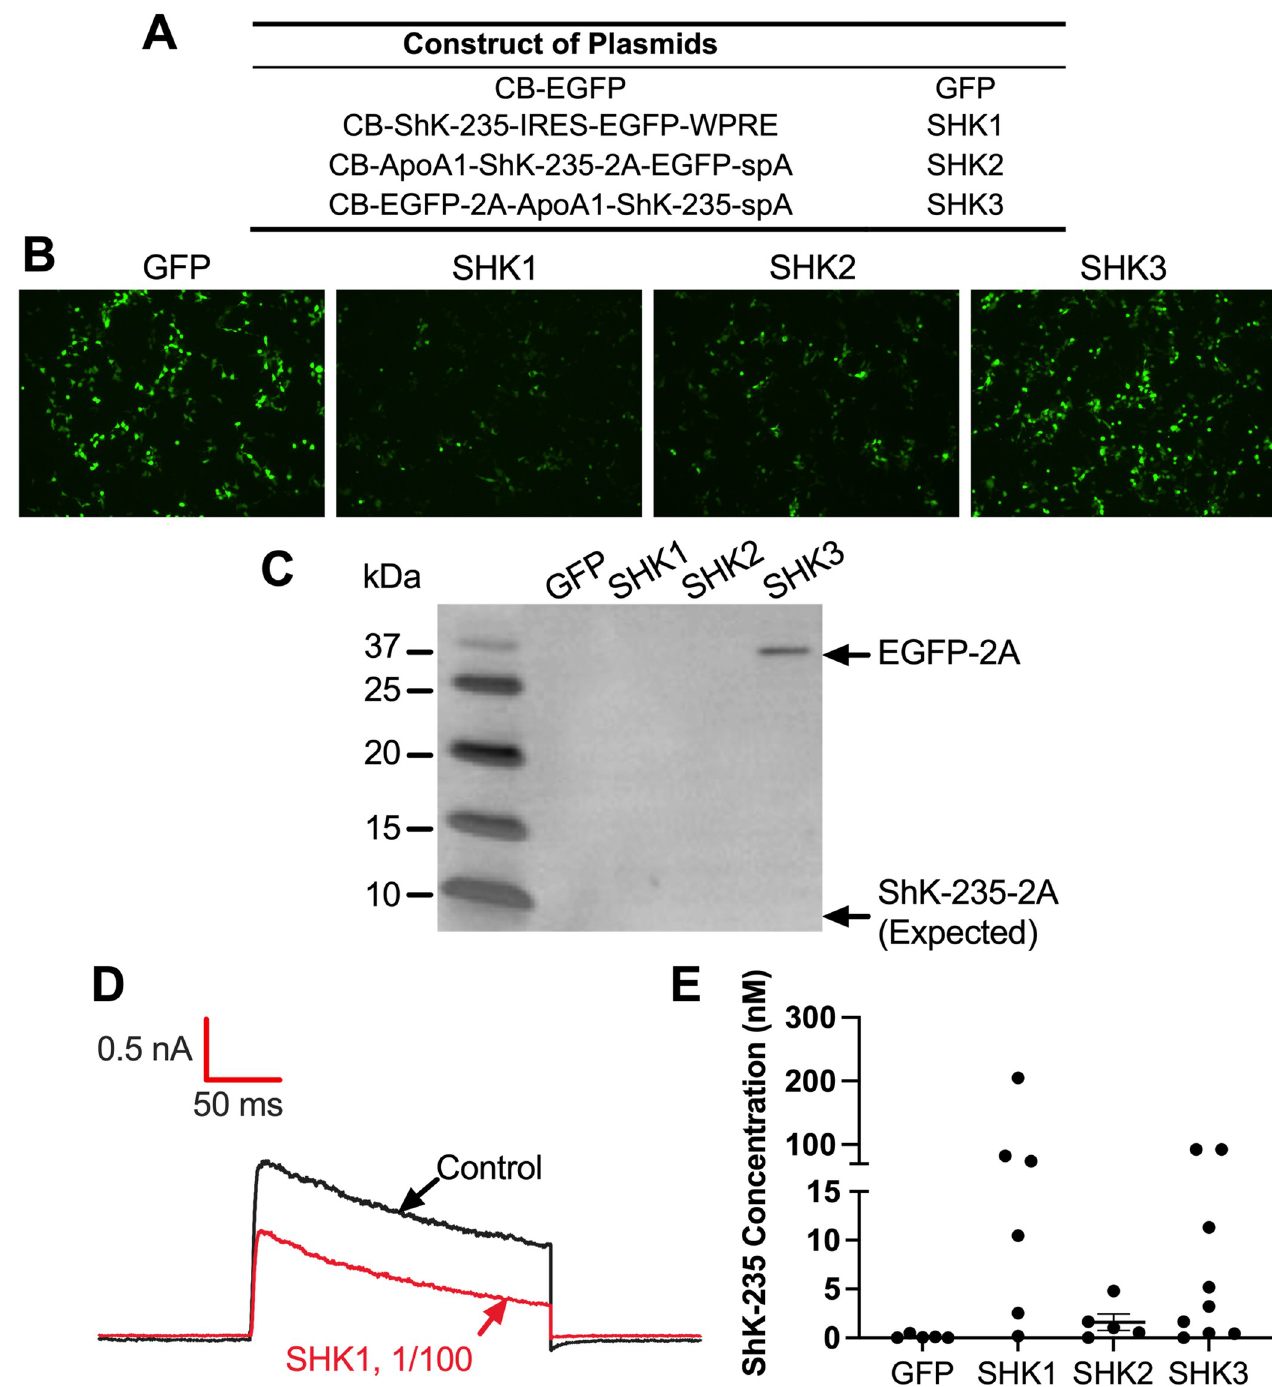
Fig 1. Design and characterization of AAV8-ShK-235 vectors. (A) Constructs used to express EGFP (GFP) or ShK-235 (SHK1, SHK2, and SHK3). (B) Representative fluorescence microscope images of HEK293T cells 72 hours after transfection with GFP, SHK1, SHK2, or SHK3 plasmids (20 μ g of specific plasmid + 60 μ g of 1 m/mL of PEI). (C) Western blot showing the detection of the 2A peptide in the supernatants of the HEK293T cells transfected with GFP control, SHK1, SHK2, or SHK3 plasmids, attached to either EGFP (32.7 kDa) or ShK-235 (4.1 kDa). Supernatants were tested without further purification or concentration. (D) Representative whole-cell Kv1.3 currents in L929 fibroblasts stably expressing mKv1.3 before (control) and after application of supernatants from HEK293T cells transfected with GFP control or SHK1, diluted 1:100. (E) ShK-235 concentration in supernatants from HEK293T cells transfected with GFP control, SHK1, SHK2, or SHK3 plasmids. Each data point represents a different recording. The horizontal bar represents the mean concentration.